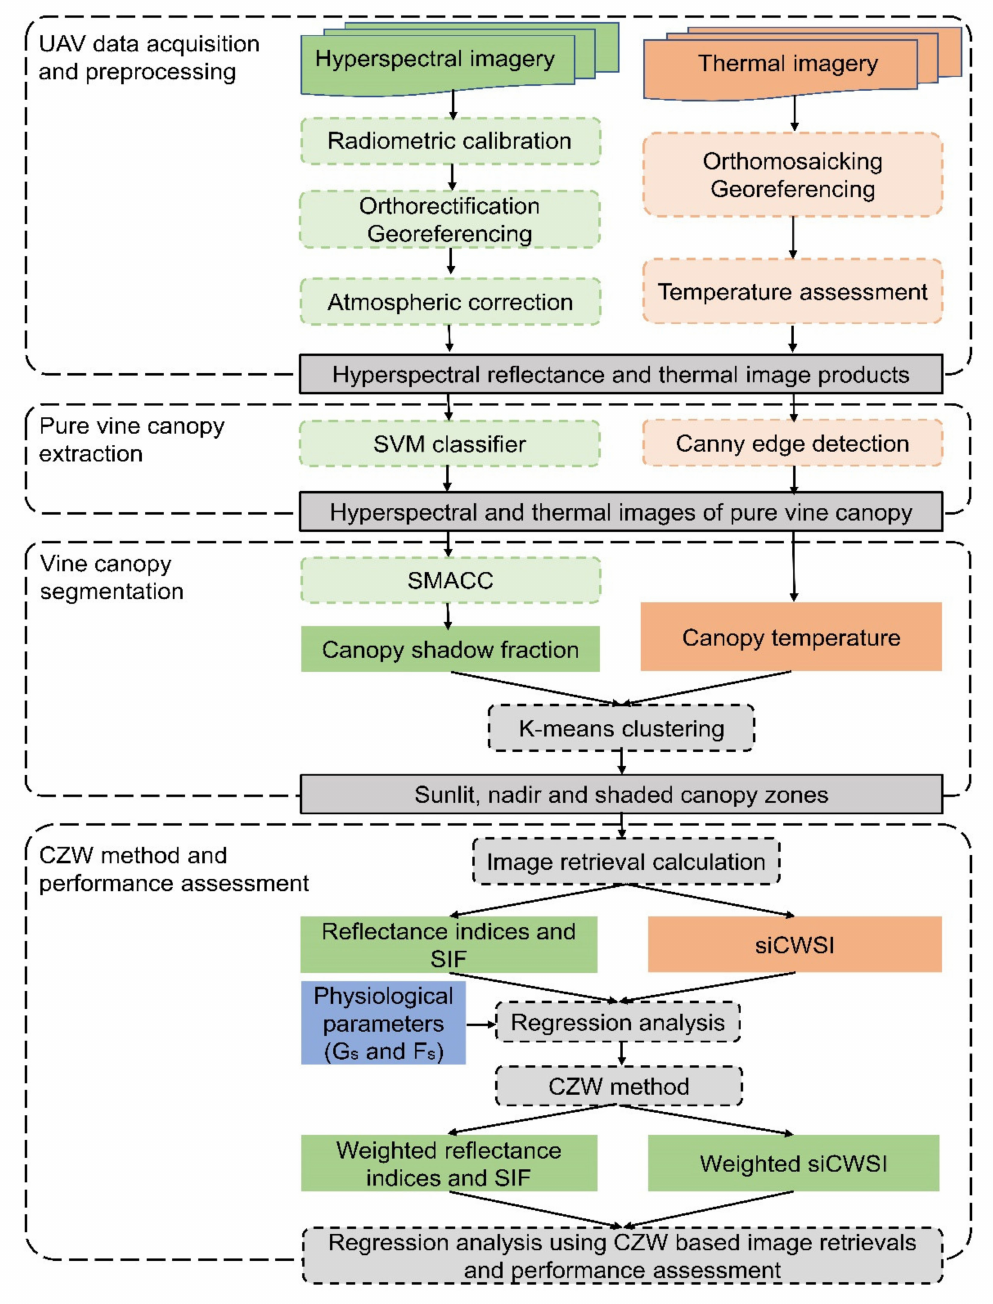
Figure 8. A workflow diagram of aerial image acquisition and preprocessing, vine canopy extraction and segmentation, and implementation of the CWZ (Canopy Zone-Weighting) method and its performance